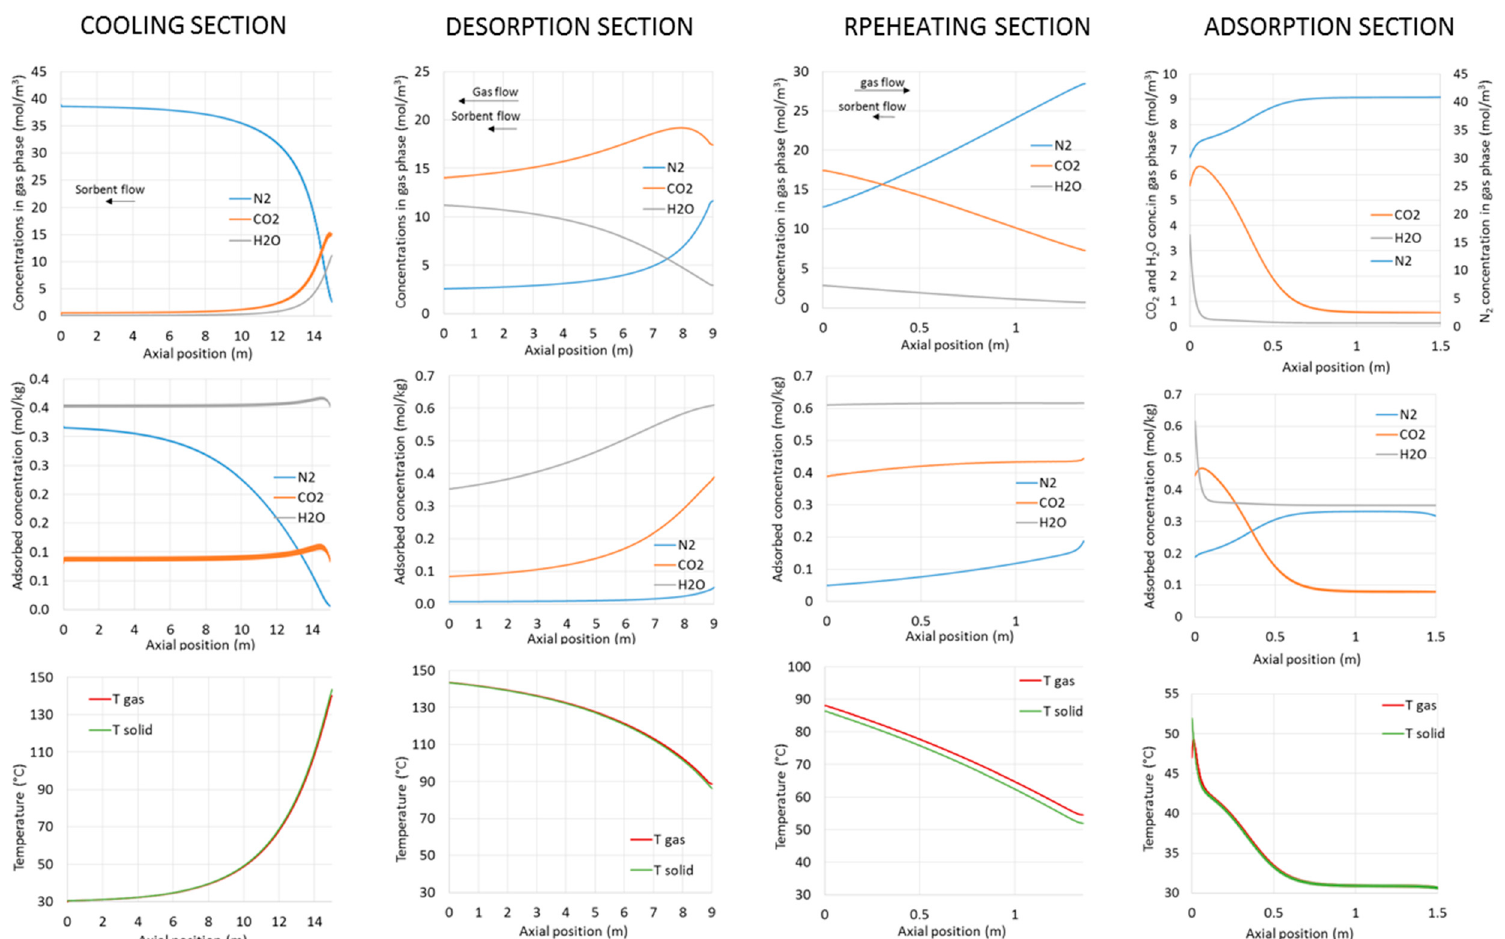
Figure 7. Gas concentration ( top raw), adsorbent loading ( middle raw), and temperature profiles ( bottom raw) along the MBTSA sections. From left to right: cooling section, desorption section, preheating section and adsorption section (Data from simulation case D-11).